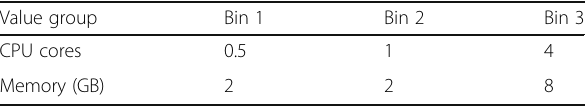
Table 3 Test load configuration groupings for each compute